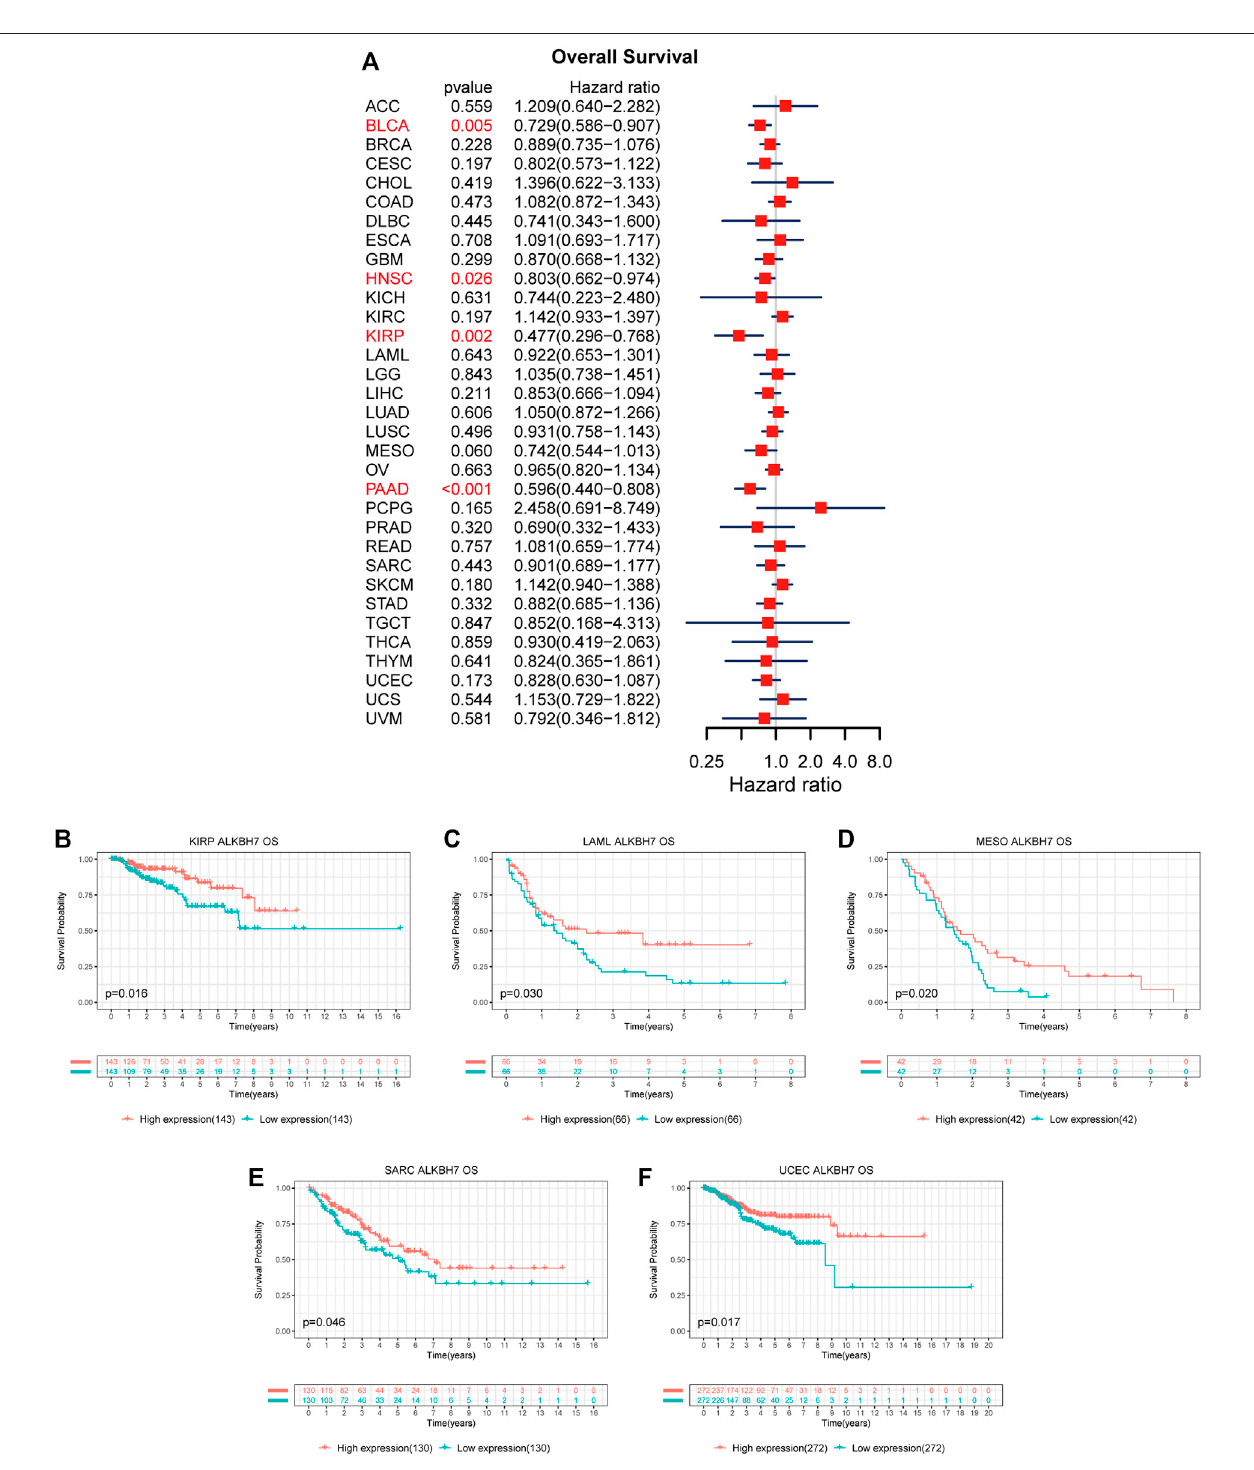
FIGURE 4 | Associations between ALKBH7 expression and OS of patients with cancer. (A) Forest plot showing the hazard ratios of ALKBH7 in 33 cancers; Kaplan-Meier survival curves of OS forpatients strati fi ed according to different ALKBH7 expression pro fi les in KIRP (B) , LAML (C) , MESO (D) , SARC (E) and UCEC (F) .